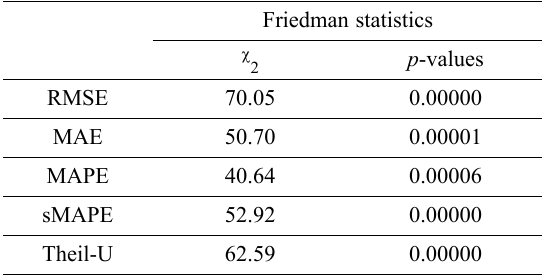
Table 9. Results of the Friedman’s test statistics in terms of forecast evaluation